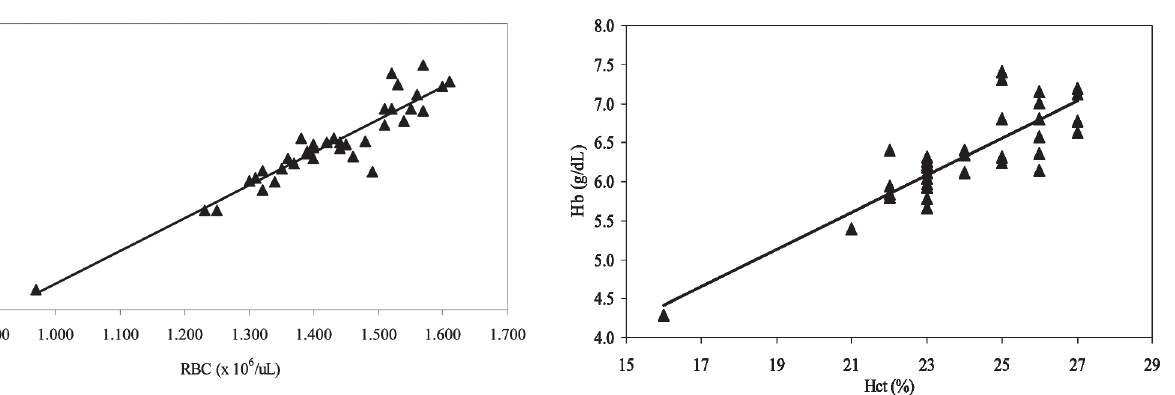
Fig. 4. Relationship between hematocrit and hemoglobin concentration ( r = 0.860; p<0.001) in C . temensis (n = 40) farmed in central Amazon.